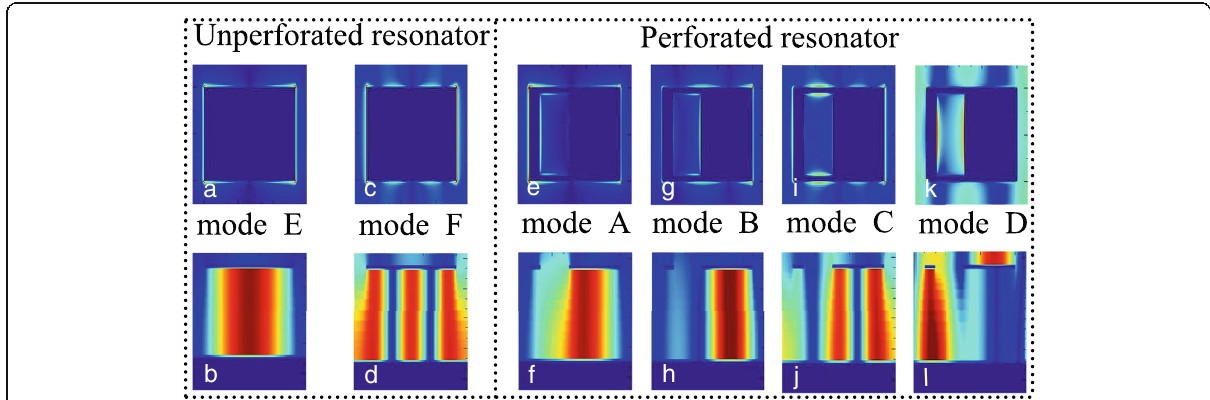
Fig. 4 a and c show the | E| field distributions of the frequency points E and F of the unperforated rectangular resonator, respectively. b and d provide the | H y | field distributions of the frequency points E and F of the unperforated rectangular resonator, respectively. e , g , i , and ( k ) show the | E| field distributions of the frequency points A , B , C , and D of the perforated rectangular resonator, respectively. f , h , j , and l give the | H y | field distributions of the frequency points A , B , C , and D of the perforated rectangular resonator,